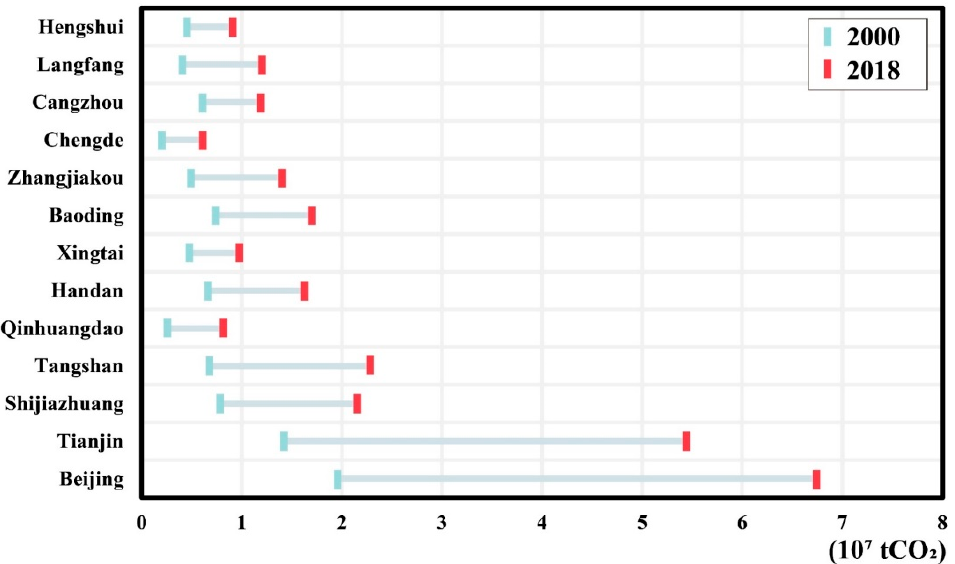
Figure 7. Variations in the CO 2 emissions of 13 cities located in Beijing – Tianjin – Hebei from 2000 to 2018.